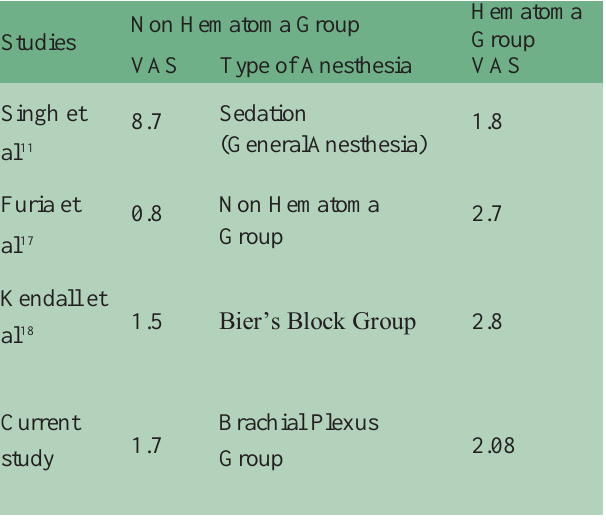
Table 6 : Comparison of VAS in different studies in the Non Hematoma and Hematoma